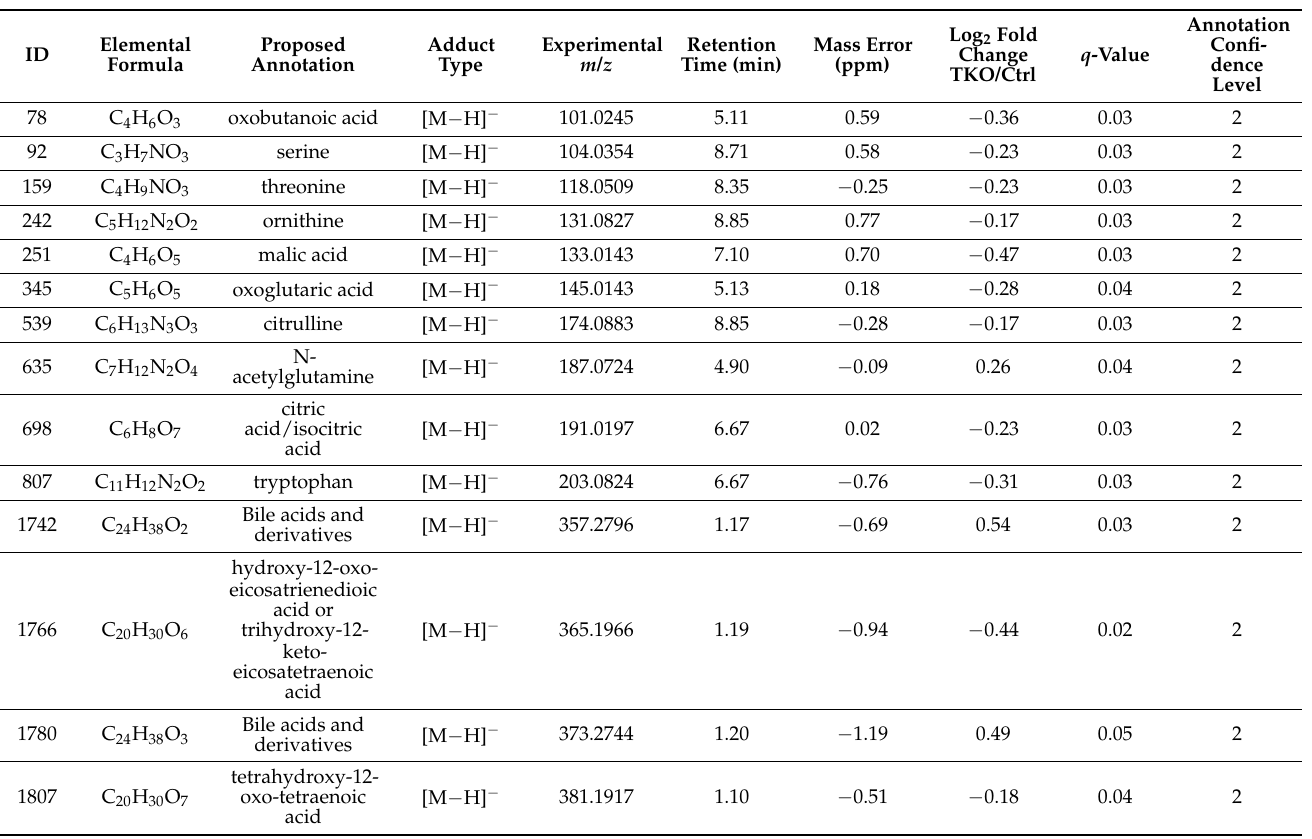
Table 1. Metabolite annotations for the 14 selected features in the HILIC dataset. Proposed metabolite annotation, experimental monoisotopic m / z value, elemental formula, chromatographic retention time (min), mass error (ppm), main adduct type detected, abundance log-transformed fold changes, and metabolite annotation confidence level are shown. Fold changes were calculated as the base 2 logarithm of the average abundance ratios between TKO and TKO controls in the 37–60 %lifetime group. Positive values indicate higher levels in TKO serum samples and negative values indicate lower levels in TKO serum samples compared to TKO controls. The confidence level for metabolite annotation was assigned as (1) exact mass, isotopic pattern, retention time, and MS/MS spectrum of a chemical standard matched to the feature. (2) exact mass, isotopic pattern, retention time, and MS/MS spectrum matched to an in-house spectral database or literature spectra (3) putative ID assignment based only on elemental formula match. (4) unknown compound. Compound classes are provided for features with low annotation confidence